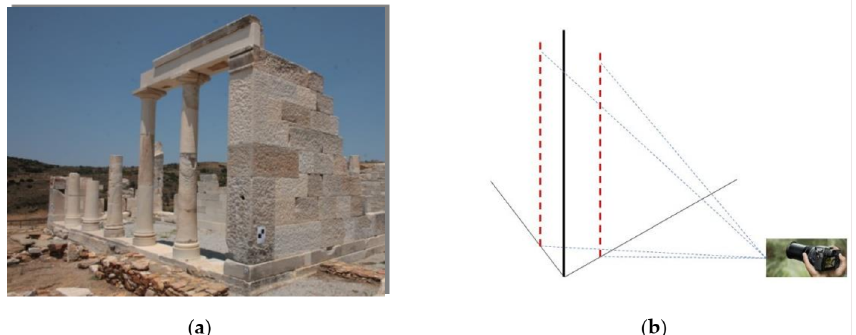
Figure 13. Representation of the problematic scenario at the time of image acquisition using real data from the temple of Demeter ( a ) and the problem analyzed in a drawing ( b